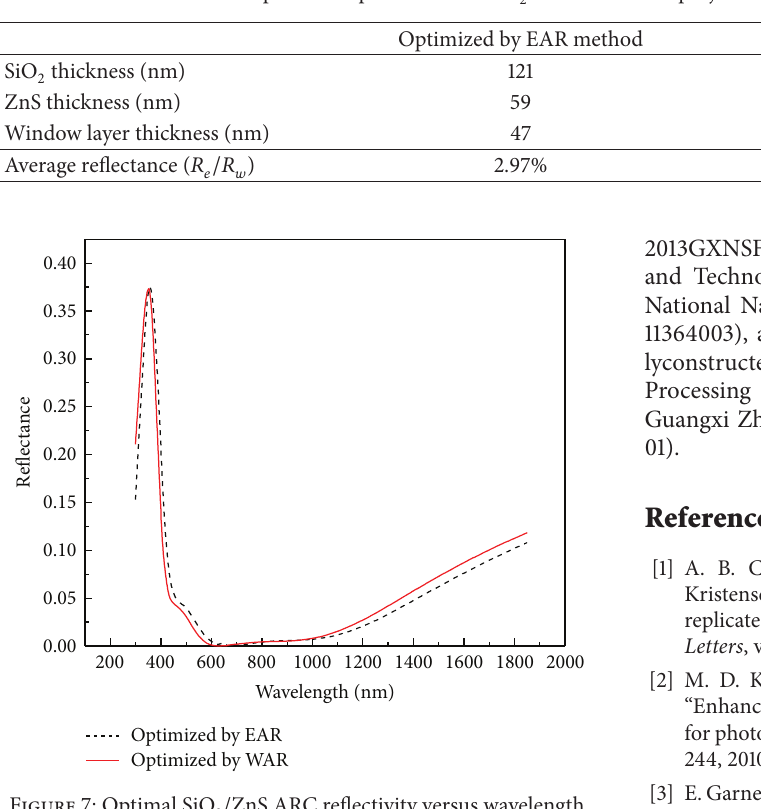
Figure 7: Optimal SiO 2 /ZnS ARC reflectivity versus